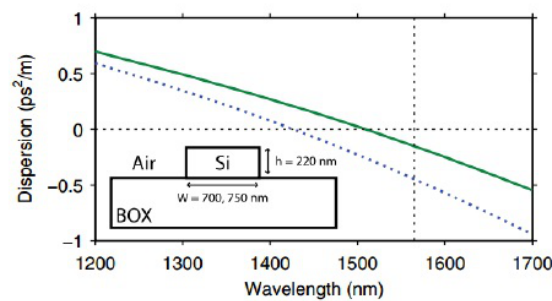
Fig. 10. Interferometric setup to measure the pulse to pulse co- herence of the generated supercontinuum. Adapted from refer- ence